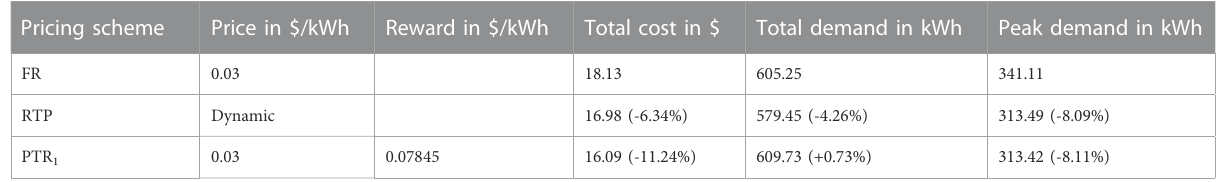
TABLE 10 For different values of loss aversion. Season Pricing scheme